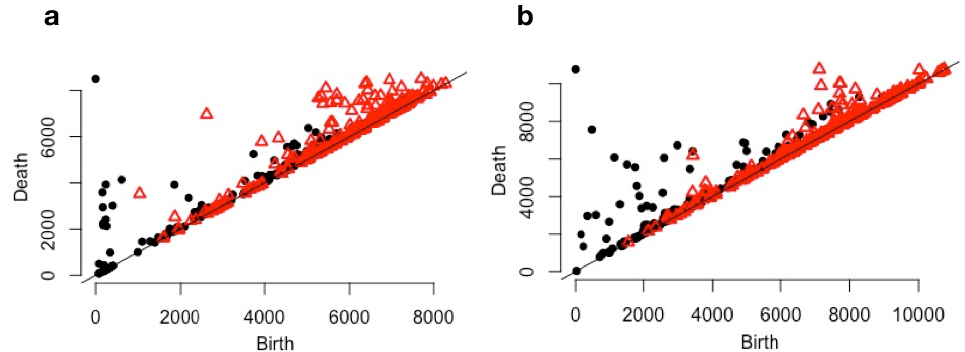
Figure 6. Persistence diagrams of the crystallized PC surface with ( a ) 4 min of immersion time and ( b ) copied surface by PDMS